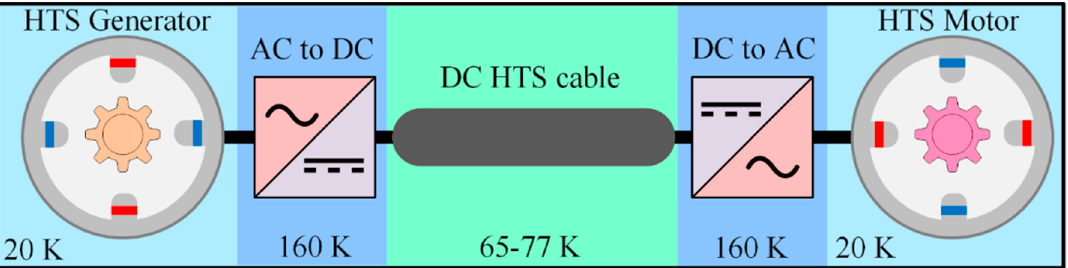
Figure 1. The structure of HTS devices in a cryo-electric aircraft, cooled down to cryogenic temper- atures.